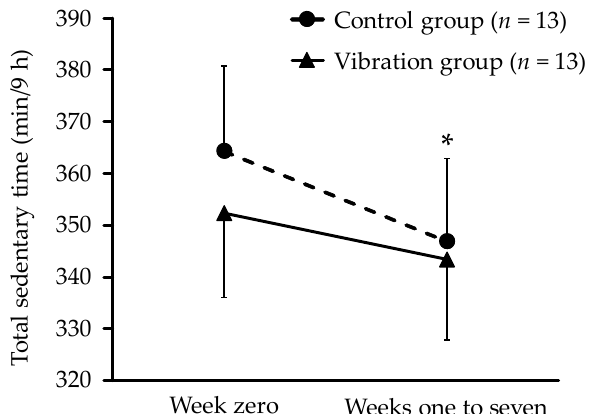
Figure 3. Change in sedentary time from week zero to weeks one to seven. Each data point represents mean value for all participants, with missing data replaced by baseline observation carried forward. Error bars indicate standard error. * p < 0.05 for within-group differences.